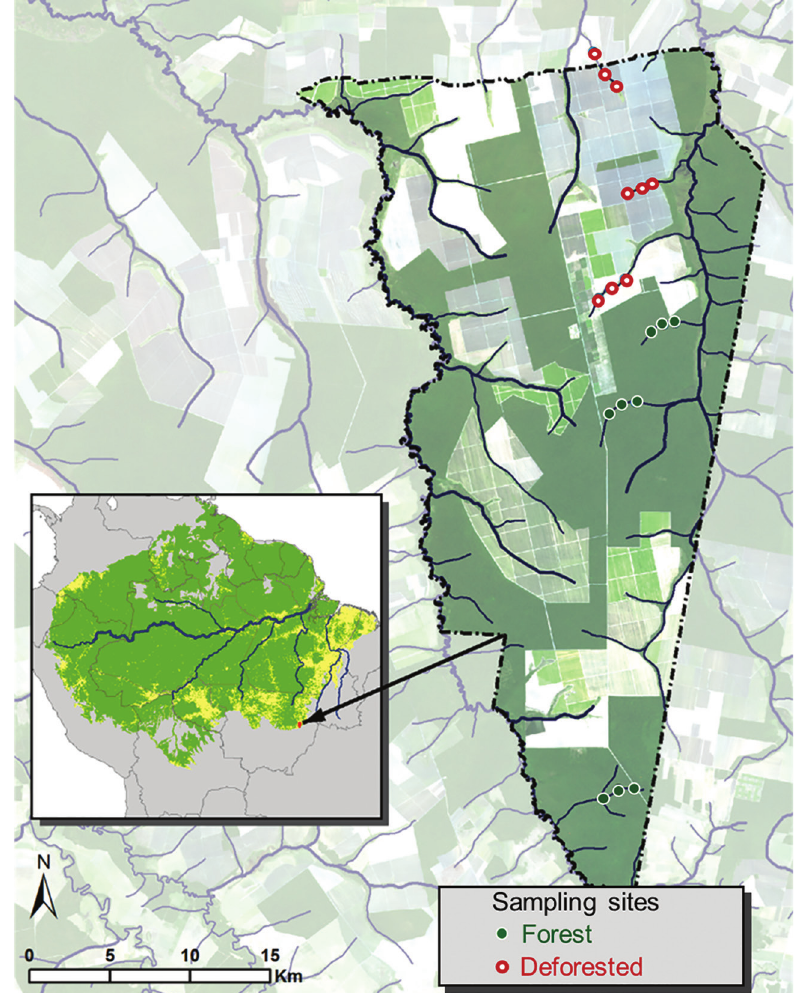
Fig. 1 . Location of study area and sampling sites. The inset shows the location of Tanguro Ranch in the southeastern region of the Amazonian Arc of Deforestation, with green representing closed canopy forests, yellow representing deforested areas and uncolored areas representing native savannas. From South to North, streams sampled are APPM, APP2A, APP2, TAN1, TAN2, and TAN3. See the text for